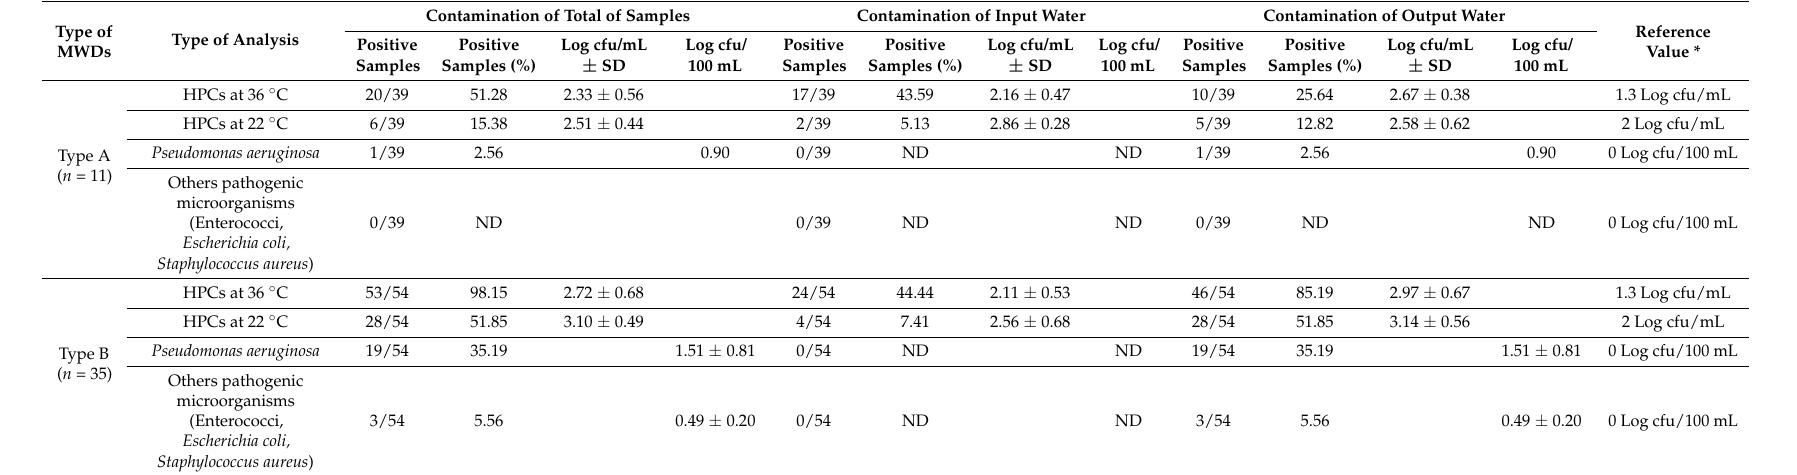
Table 2. Total contamination of total samples of MWDs of Type A and B with respect to the sampling point (input and output): HPCs at 36 ◦ C, HPCs at 22 ◦ C, Pseudomonas aeruginosa , and other pathogenic microorganisms (Enterococci, Escherichia coli , and Staphylococcus aureus